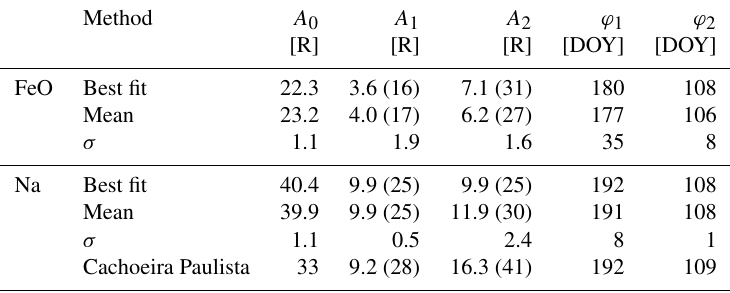
Table 1. Coefficients of harmonic analysis.